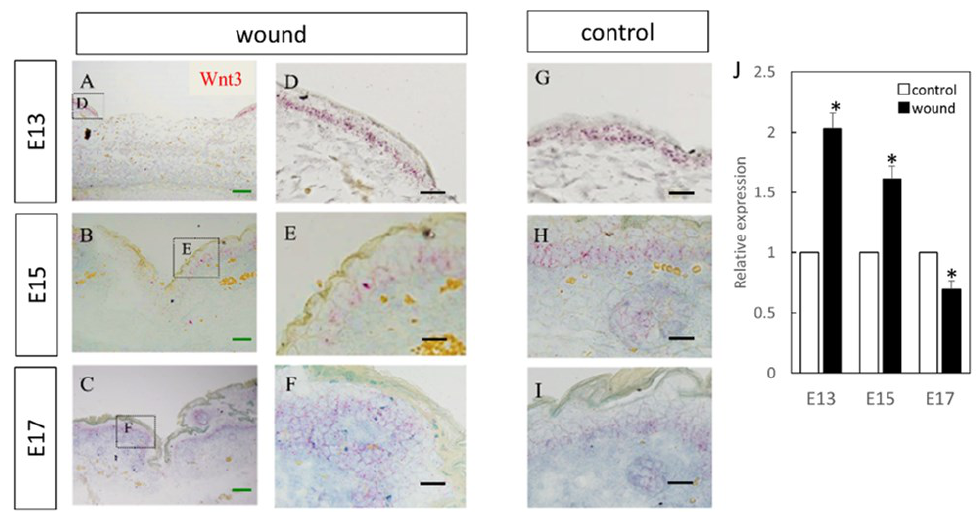
Figure 1. Measurement of Wnt3 expression in the wound by in-situ hybridization and real-time quantitative PCR. Wnt3 expression is indicated in red in the tissue. Wnt3 was specifically expressed in the epidermal layer. ( A – C ) Weakly magnified images of the wound perimeter. ( D – F ) Strongly magnified images of the wound margin. ( G – I ) Observed images of the normal area. ( J ) Decreased expression of Wnt3 at the wound site compared to the normal site at E17. In contrast, Wnt3 expression was increased at the wound sites on E15 and E13. * p < 0.05. ( A – C ) Scale bar = 200 μm. ( D – I ) Scale bar = 100 μm.